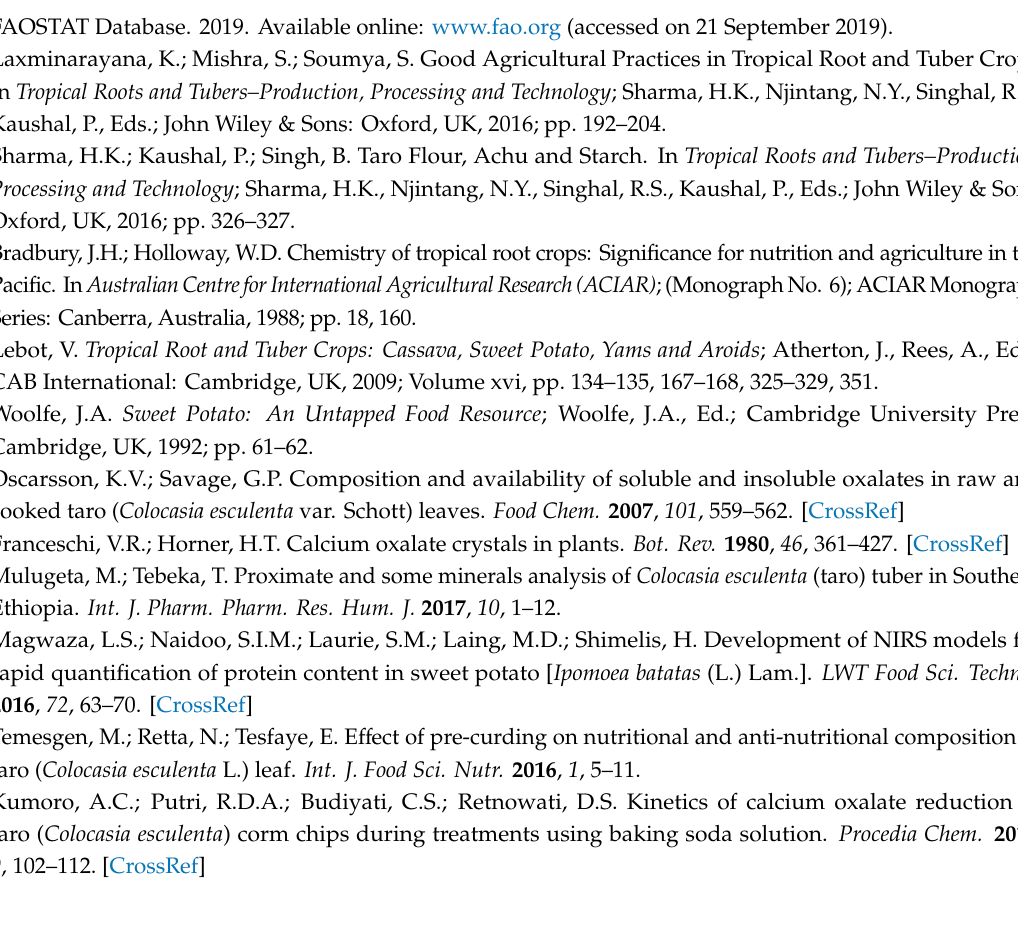
s1, Table S1: Taro quality constituents of the flour obtained by laboratory reference analysis (1st trial) and NIRS prediction (2nd trial) for both corms and shoots submitted to control and drought conditions, Table S2: Pearson correlations of taro corms and shoots, from the 1st agronomic trial, Table S3: Sweet potato quality constituents of the flour obtained by laboratory reference analysis (1st trial) and NIRS prediction (2nd trial) for both tuber and shoot organs, under control and drought conditions, Table S4: Pearson correlations of sweet potato tubers and shoots, from the 1st agronomic trial, Table S5: Pearson correlations of taro corms and shoots, from the 2nd agronomic trial, Table S6: Pearson correlations of sweet potato tubers and shoots, from the 2nd agronomic